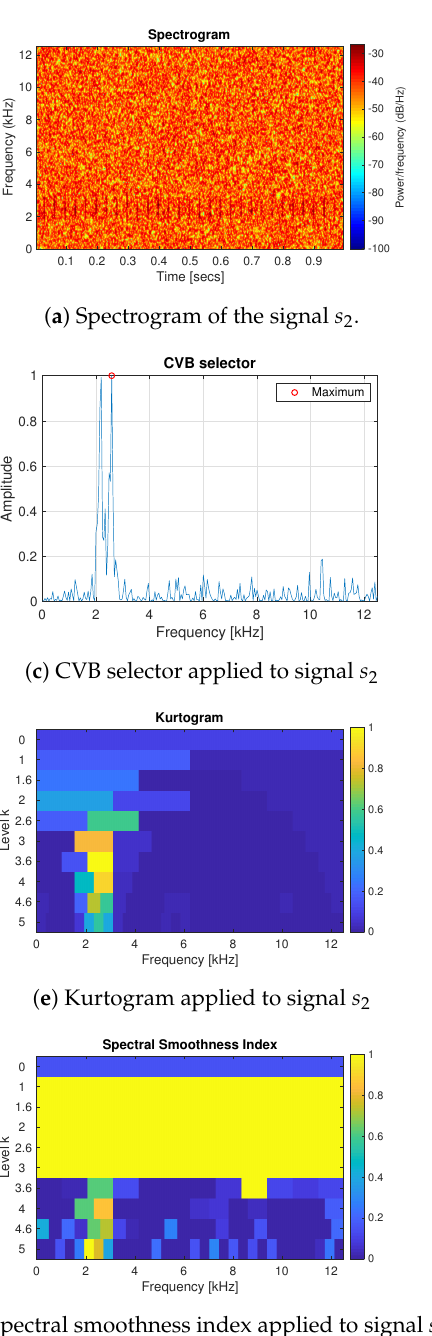
Figure A2. Normalized results of the informative frequency band selection for 7 different methods for the signal s 2